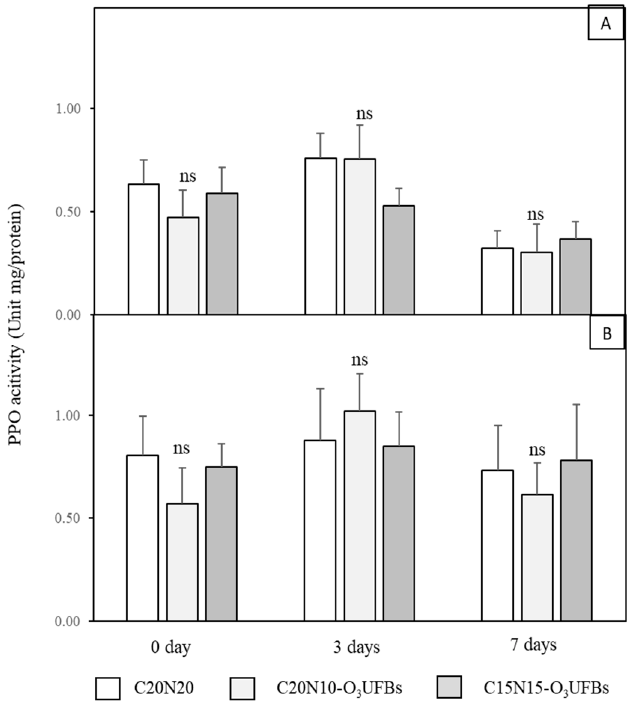
Figure 10. PPO activity of mesocarp of trimmed coconuts dipped in C 20 N 10 -O 3 UFBs and C 15 N 15 - O 3 UFBs compared with C 20 N 20 when stored at 2 °C for 0 days (before storage) ( A ) and 30 days ( B ). After storage, all coconut fruits were transferred to 8–10 °C for 7 days and PPO was evaluated on days 0, 3, and 7. ns: not significantly different.